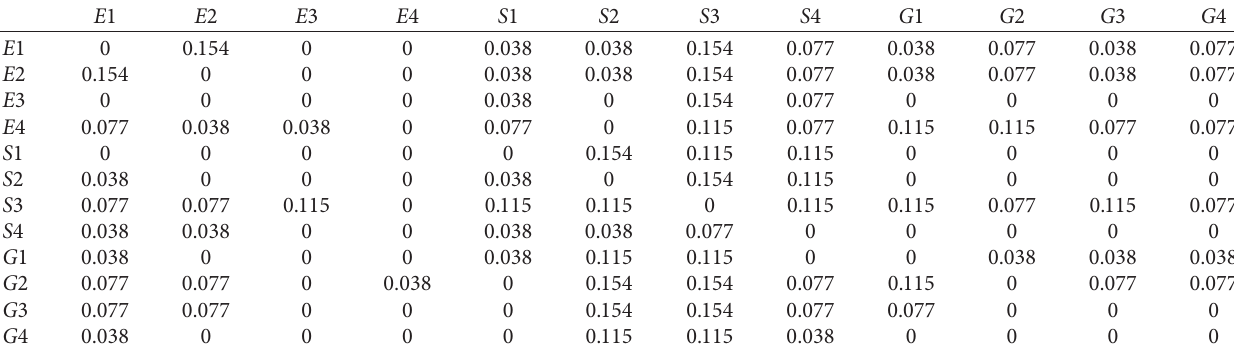
Table 28: Normalized matrix of sustainability criteria in deterministic condition.